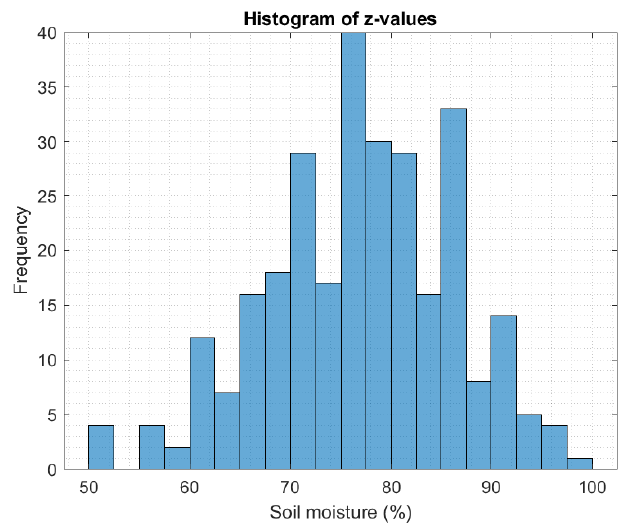
Figure 9. Example histogram of the initial soil moisture of the potato